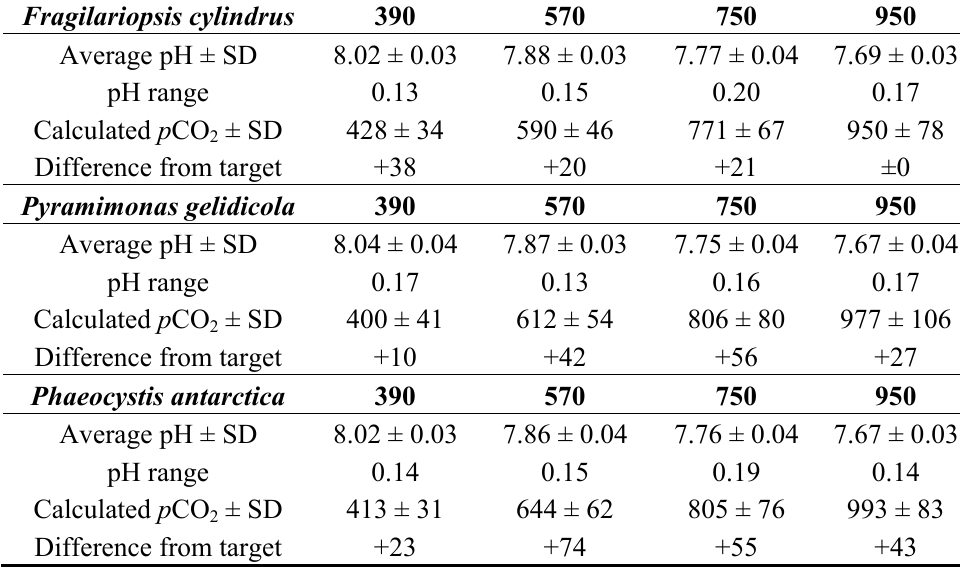
Table 1. Measured pH and calculated p CO during the continuous culture experiments. 2 (µatm). SD = standard deviation, range = difference between Headings are target p CO 2 highest and lowest recorded pH, measured p CO values were calculated using CO2SYS 2 from alkalinity and pH, positive (negative) values mean the actual CO concentration was 2 higher (lower) than the target